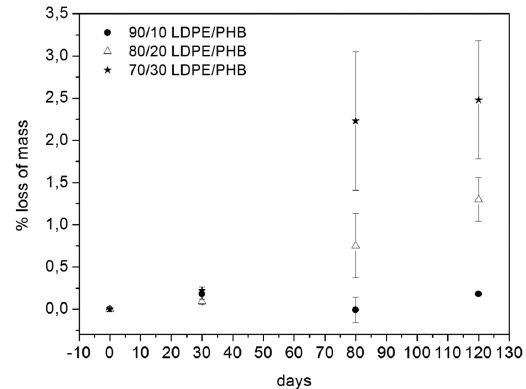
Figure 3. Percentage of loss of mass of LDPE/PHB binary blends in different intervals of time.